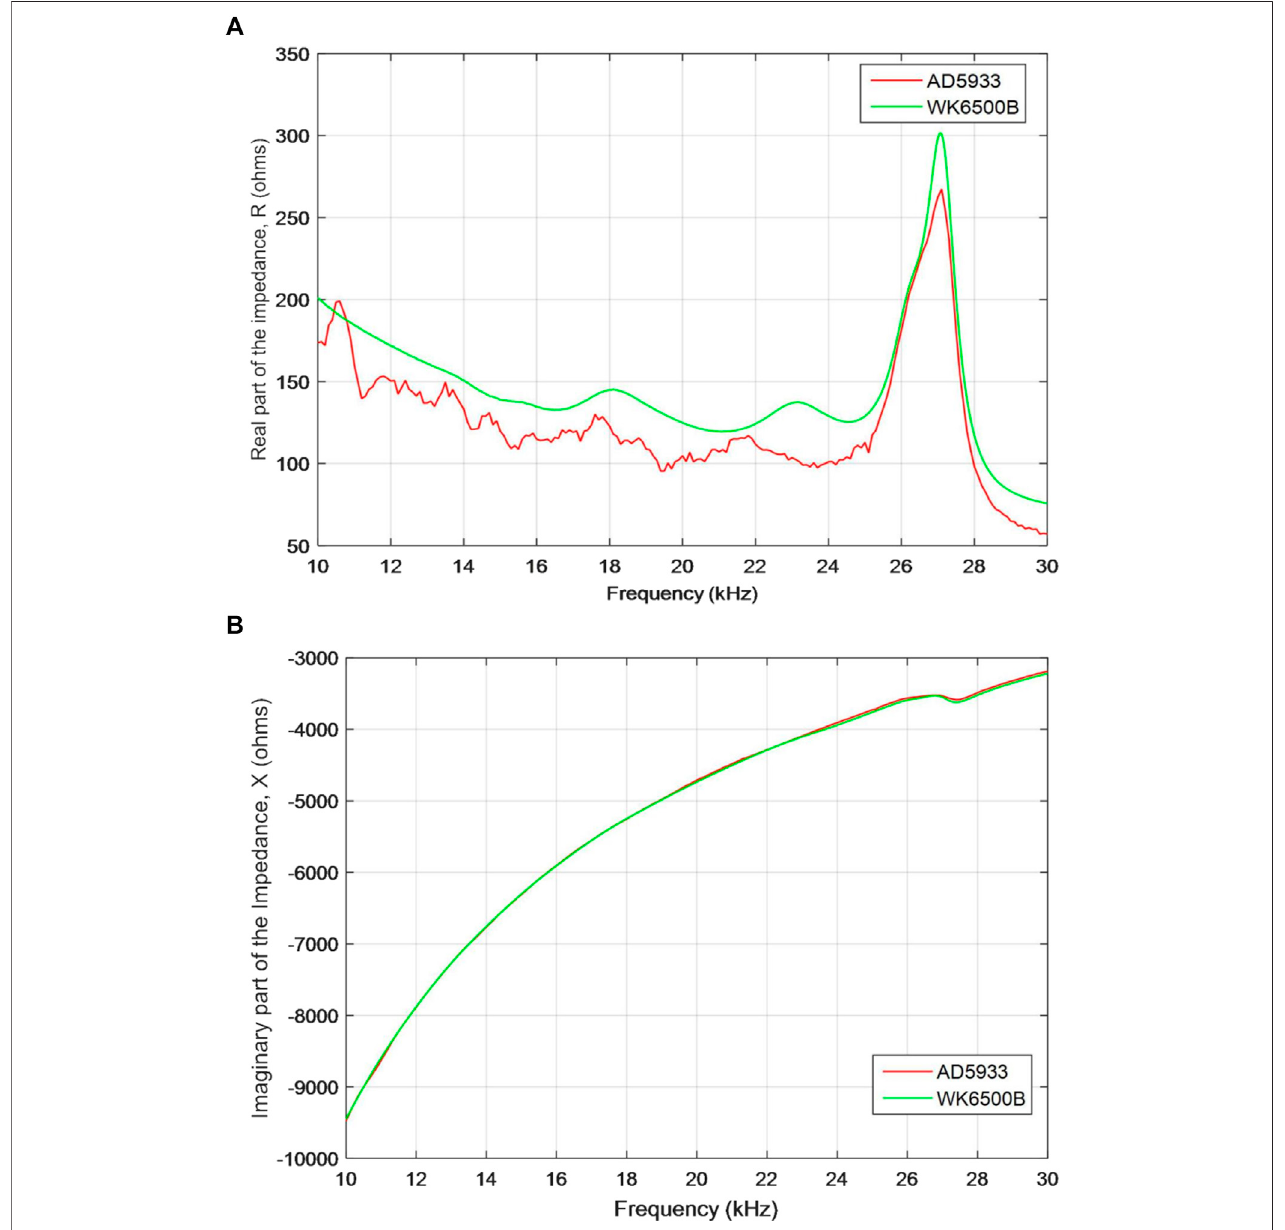
FIGURE 2 | Comparison of impedance measurements for WK6500B and AD5933: (A) the real part, and (B) the imaginary part of the impedance.